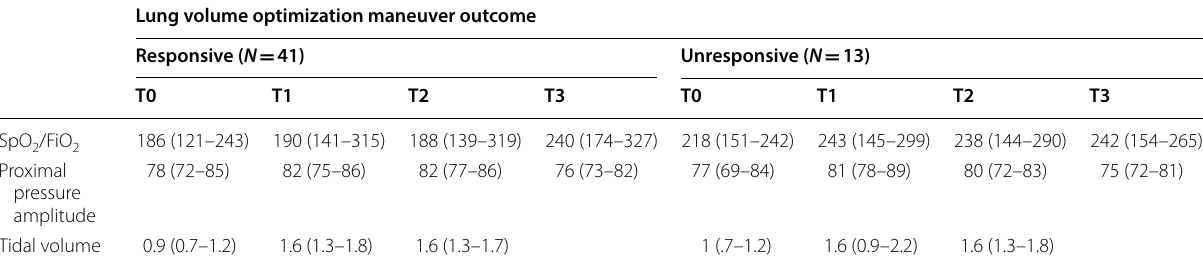
Data are depicted as median (25–75 interquartile range) or absolute